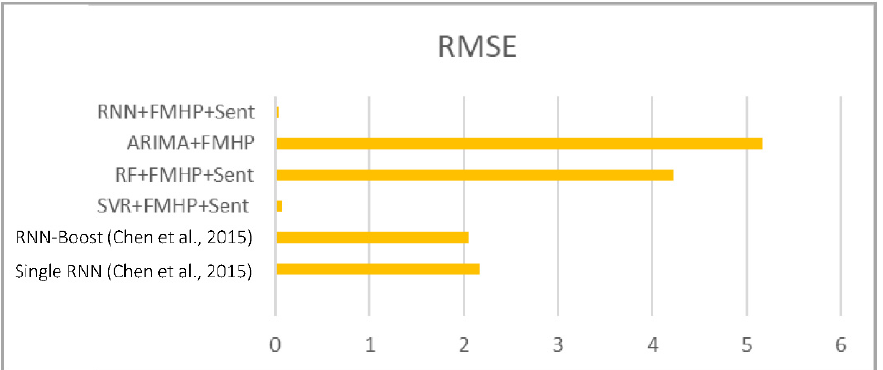
The HP filter minimizes fluctuations in time series against parameters that approach linear trends. FMHP is an extended HP filter that produces trend and cyclical components, lowers the endpoint base (EPB), and performs comparatively better than the HP filter. The trend component produced by the BK filter or CF filter slightly changes the time series curve. In our experiments, we found that the trend component produced by the HP filter preserved the financial series curve hence improving endpoint bias. We conducted several experiments using different approaches to compute the per- formance of predicting stock price and our proposed model. Both technical and content features were combined to improve prediction accuracy. The performance of machine learning methods was investigated on original data, as well as applying some noise re- duction techniques, including HP and FMHP filters. We found that HP and FMHP are effective for noise reduction and work efficiently to improve the model’s prediction accu- racy. In addition, the technical and content features complement each other and help re- duce MAPE and RMSE error rates. 6. Conclusions This study aimed to investigate the best combination of machine learning and noise reduction techniques for predicting the closing stock price. Two types of features were obtained, technical features were derived from the historical stock data, while content fea- tures were obtained from official accounts of Twitter. Technical and content features were combined to improve prediction accuracy. We used five machine learning approaches, three traditional, and two deep learning-based approaches. Two approaches for time se- ries data denoising were evaluated: FMHP and HP. We performed several experiments in combination with machine learning approaches for prediction of AAPL stock value pre- diction using 14 days of historical data. The proposed model using our hybrid technique and combination of ML and DL models, the FMHP noise filter, and the new technical and content features, is a powerful predictive tool for analyzing stock market price prediction, content, and financial time series. The stock market price depends not only on time series data but also on macroeco- nomic factors, and other external factors, such as the news, significantly impact the stock market price. These types of limitations lead to some issues which need to be solved for future research. In the future, we will extend our work to improve the prediction accuracy for longer historical data and reduce the processing time for deep learning methods. We also intend to validate the proposed novel features and the FMHP filter with a more di- verse dataset. Moreover, the hyper-parameter tuning is also complex. Therefore, an auto- matic hyper-parameter selection approach will be adopted to obtain optimal parameters.